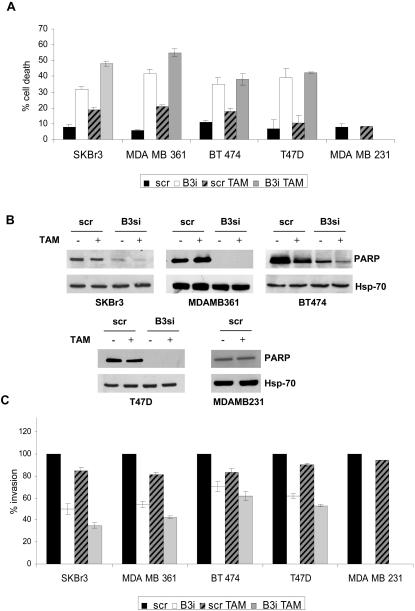
ErbB-3 expression influences survival and invasion of mammary tumor cells treated under TAM treatment.A. SKBr3, MDA-MB 361, BT474, T47D and MDAMB231 cells after three days of hormone deprivation were transiently transfected with either scrambled or specific ErbB-3 siRNA. Where specified, 24 hrs after transfection scrambled and ErbB3 interfered cells were pre-incubated for 24 hours at 37°C with TAM 2.5 µM. 48 hours following transfection, the cell death was evaluated by Trypan-blue exclusion. Statistical differences were evaluated by T test (p<0.05). B. Equivalent amounts of total cell lysate derived from the cell lines described in A were separated by SDS-PAGE and analyzed by immunobloting to evaluate the expression level of PARP cleavage. Hsp70 Ab was used to validate equivalent loading of protein in each lane. C. SKBr3, MDA-MB 361, BT474, T47D and MDAMB231 cells transfected as described in A were assayed for their ability to invade matrigel in the absence of hormone and under TAM treatment. Statistical differences were evaluated by T test (p<0.05).